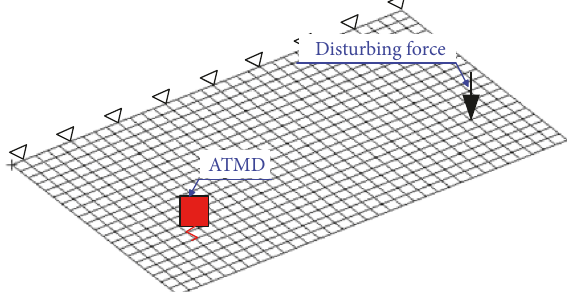
Figure 12: Model of the major structures of the damping